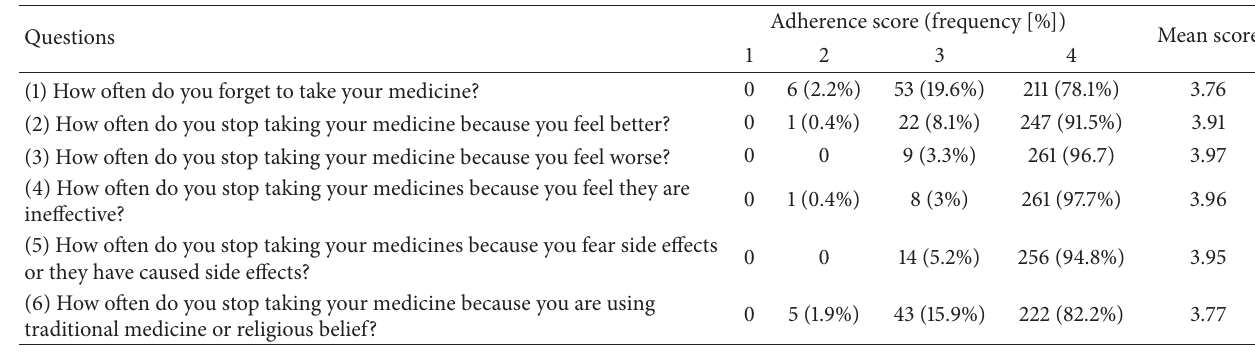
Table 3: Adherence scores, Adama, Ethiopia, 2014.